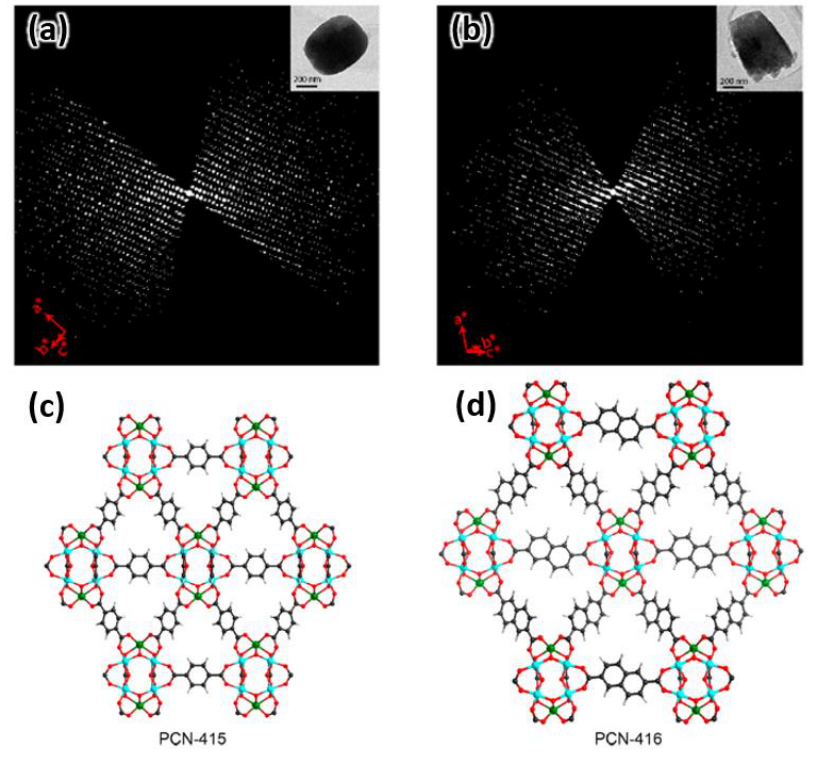
Figure 4. Reconstructed 3D reciprocal lattice of ( a ) PCN-415 and ( b ) PCN-416 from cRED data. Insets are the crystals from which the RED data were collected. ( c ) and ( d ) Structure of PCN-415 and PCN-416 built from [Ti 8 Zr 2 O 12 (RCOO) 16 ] clusters and different carboxylate linkers [85]. Reproduced from ref. [85] with permission from the American Chemical Society, copyright 2018.